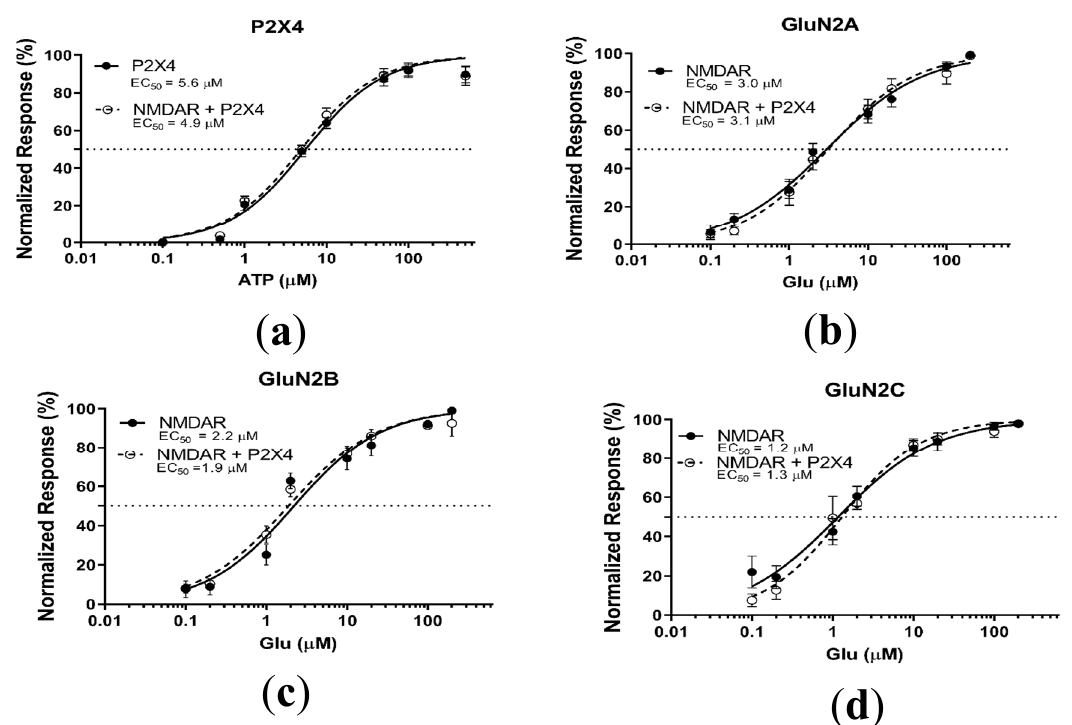
Figure A1. Comparison of the concentration-response curves for P2X4Rs or NMDARs expressed individually (depicted with solid lines) or together (depicted with dotted lines) in Xenopus leavis oocytes. ( a ) ATP concentration-response curves. EC 50 values obtained from ATP-concentration curves of individual P2X4andP2X4coexpressedwithNMDARswerenotsignificantlydifferent. ( b – d )Glutamate-concentration response curves. EC 50 values were not statistically significantly different for Glu-concentration response curves for individual GluN2A, GluN2B, GluN2C (solid lines) and each NMDAR subtype coexpressed with P2X4 (dotted lines). P2X4 and NMDARs were injected at respectively 20 ng and 10 ng cRNAs. Data represent Mean ± SEM. Statistical analysis performed using Exact sum-of-squares F-test. ( a ) p > 0.5; n = 9–12; ( b ) p > 0.5; n = 9–12; ( c ) p > 0.3; n = 9–12; ( d ) p > 0.5; n =